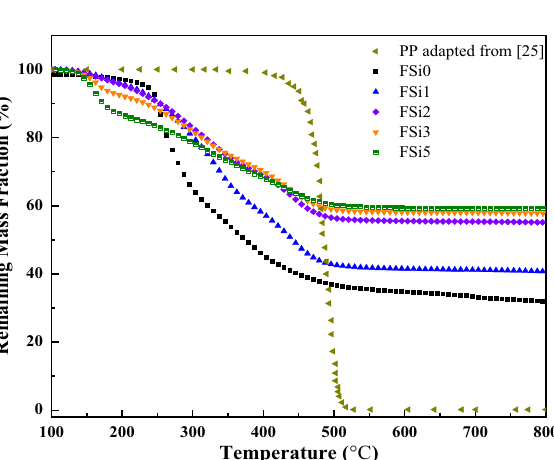
Figure 7. TGA of six fibers at a heating rate of 10 °C/min. TGA results and residual mass of PP fibers are adapted from 32